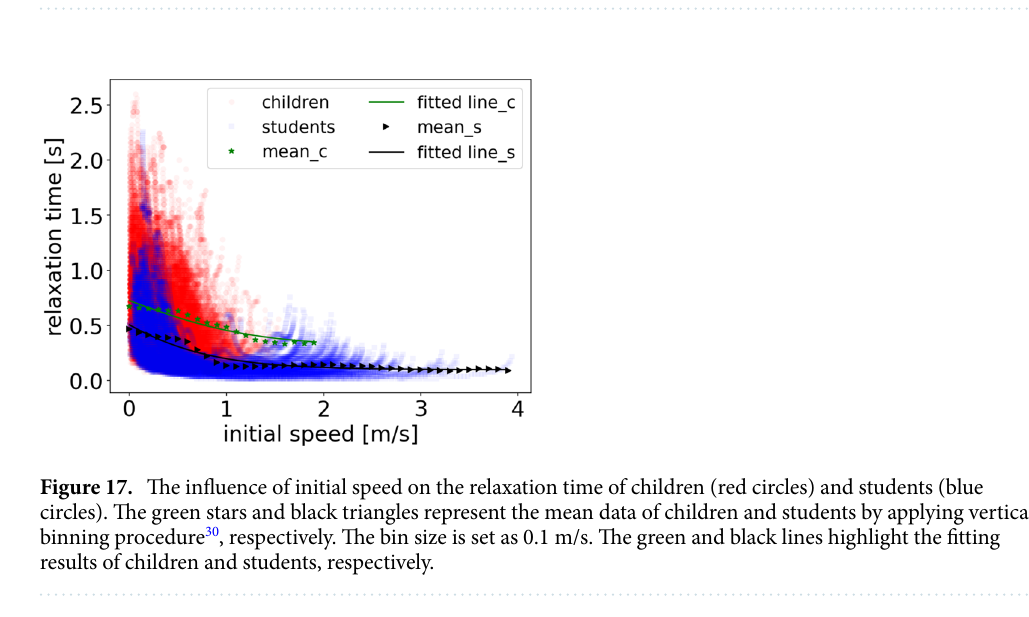
Figure 16. Cumulative distribution function of relaxation time of children (red thick line) and students (blue fine line).